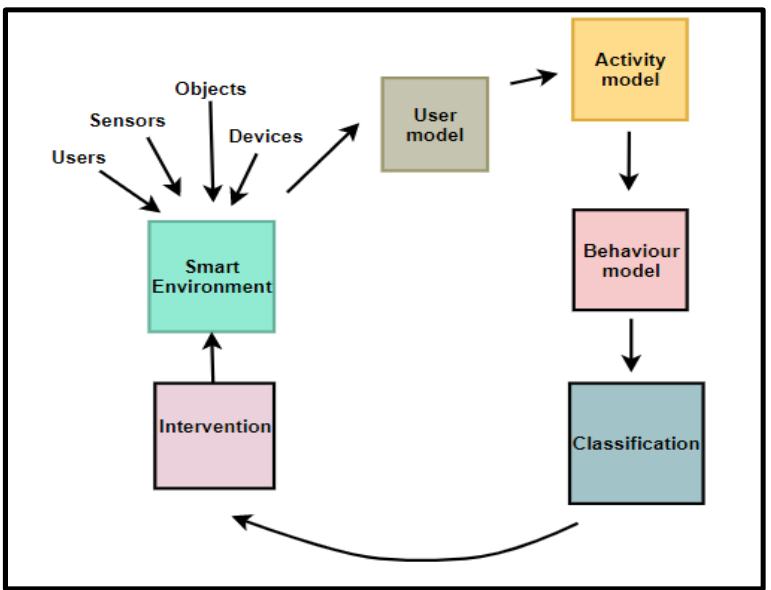
Figure 2. The Positive Behaviour Change (PBC)